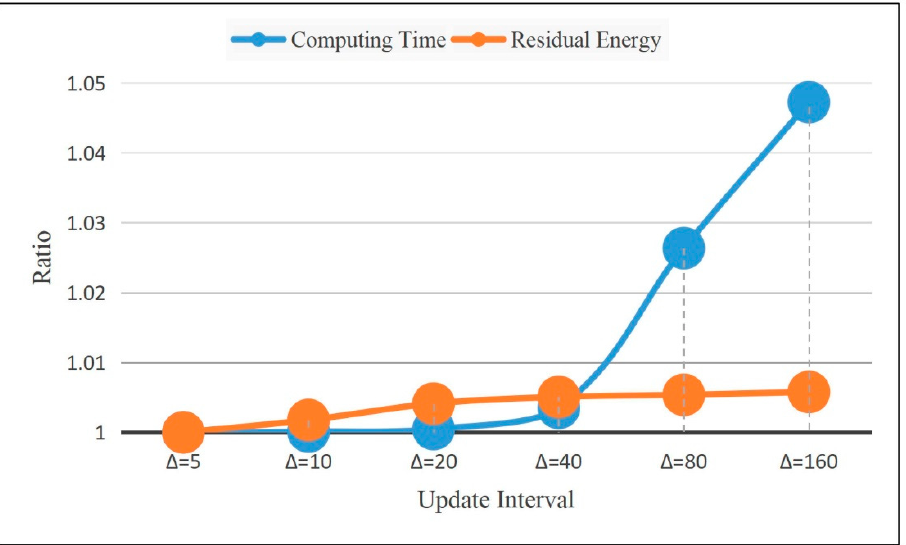
Figure 7. The corresponding calculation time and residual energy when adaptive K adopts different